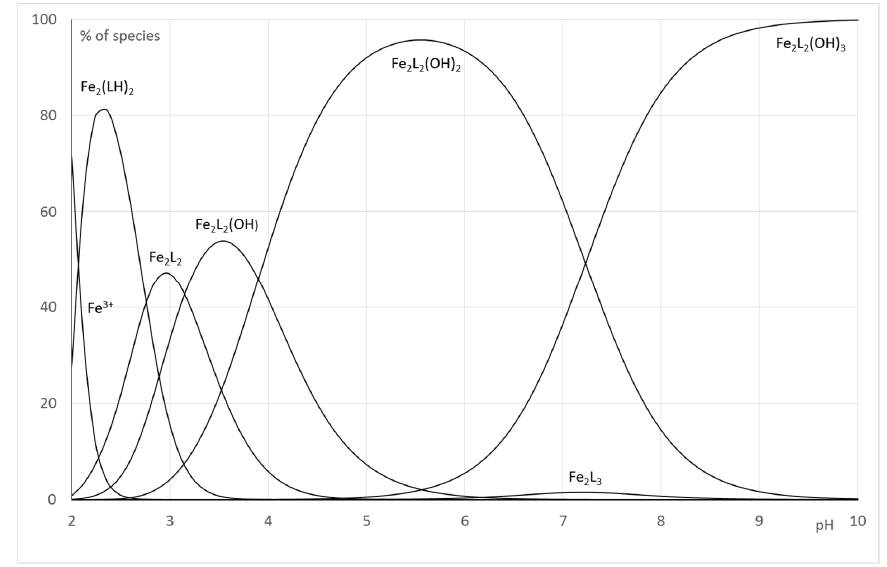
Figure 9. Distribution curves for the Fe- 2 systems (CL = 1.10 − 3 mol.L − 1 ; Cm = 2.10 − 4 mol.L − 1 ).